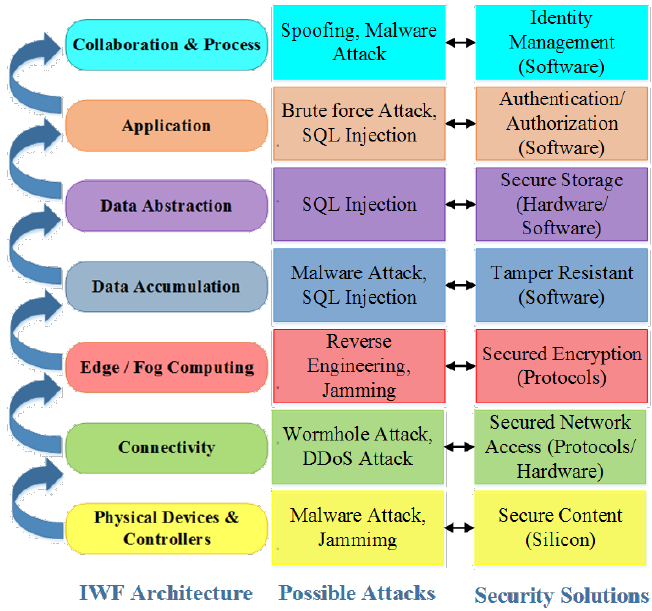
Figure 17. Possible attacks and respective security solutions of IWF